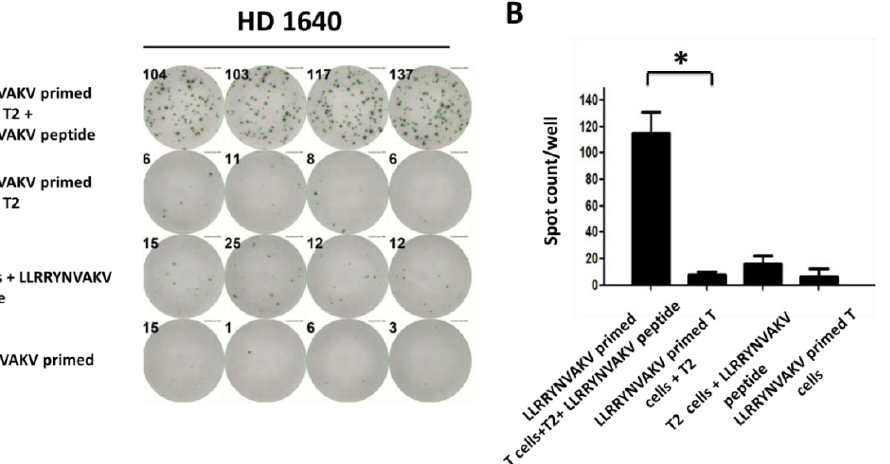
Figure 3. Recognition of peptide LLRRYNVAKV by T cells from a healthy donor (HD 1640). T cells from healthy donors were weakly stimulated with SOX11-derived LLRRYNVAKV-pulsed mature DCs. After two stimulation cycles, T cell cultures were detected for the activation of peptide-specific T cells. A total of 2 × 10 4 primed T cells were added to 1 × 10 5 peptide-loaded T2 target cells/well at an effector-cell-to-targeT cell ratio of 1:5. Primed T cells added to unloaded T2 cells served as a negative control group. Primed T cells and peptide-loaded T2 cells served as a background group.